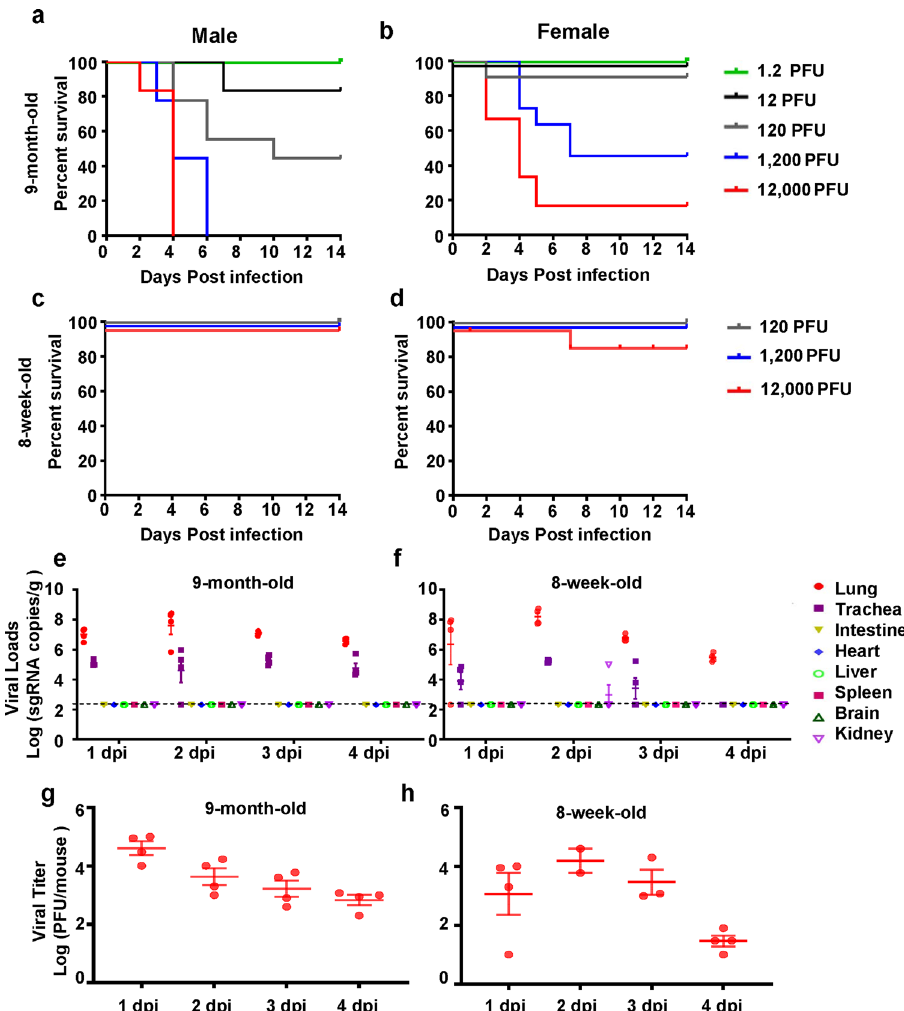
Fig. 1 MASCp36 is highly virulent in 9-month-old mice. a – d Survival curve of BALB/c mice upon challenge with MASCp36. Groups of female or male 9- month-old BALB/c mice and 8-week-old BALB/c mice were infected intranasally with the indicated doses of MASCp36, and the clinical symptoms and mortality were recorded for 14 days ( n ≥ 6 per group). e , f Replication dynamics and tissue distribution of SARS-CoV-2 sgRNAs in mice infected with MASCp36. Groups of 9-month-old BALB/c mice were i.n. inoculated with 12,000 PFU of MASCp36, and sacri fi ced at 4 dpi. All the indicated tissue samples were collected and subjected to viral sgRNA load analysis by qRT-PCR. Dash lines denote the detection limit. Data are presented as means ± SEM ( n = 4 per group). g , h Infectious viral titers in lung tissues in mice infected with MASCp36 were detected by plaque formation assay. Data are presented as means ± SEM ( n = 4